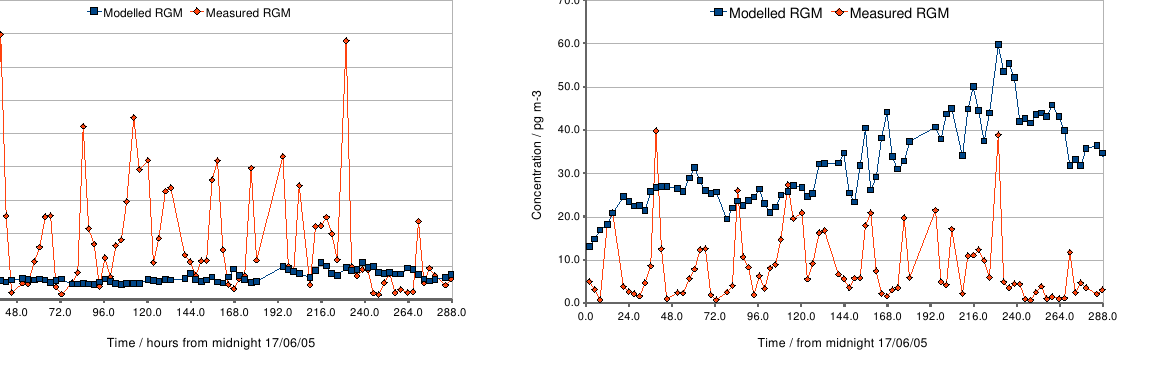
Fig. 6. The measured and modelled RGM concentration, assuming all reaction products contribute to RGM and using the Hg 0 + O 3 reaction rate constant from Pal and Ariya